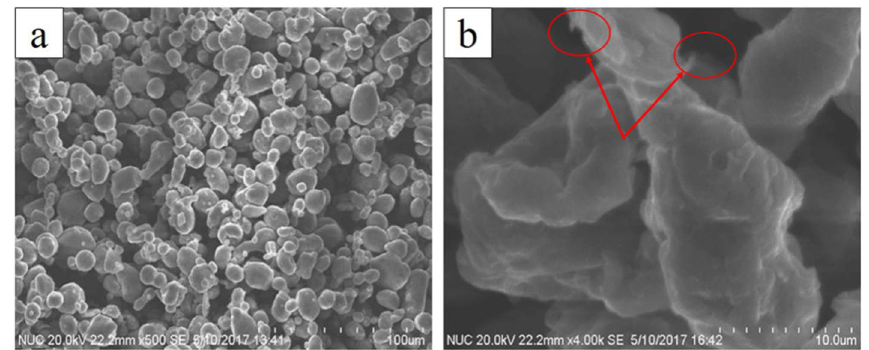
Figure 1. The SEM observation of the mixed powder after grinding ( a ) low multiples; ( b ) high multiples.